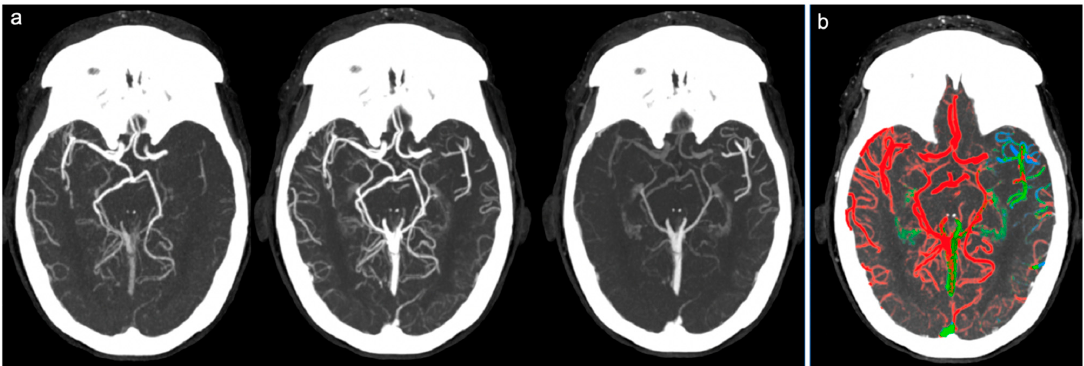
segment occlusion with intermediate pial artery filling; ( b ) ColorViz map shows predominant green